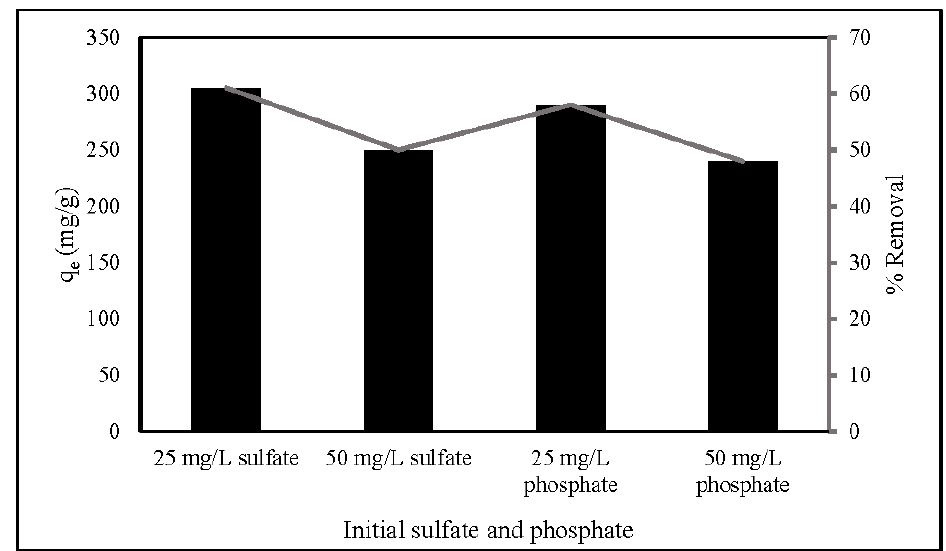
Figure 9. Effect of anions on nitrate adsorption. (10 mg of ZLCH-Fe; initial NO 3 : 100 mg/L; contact time: 270 min; pH: 7.)